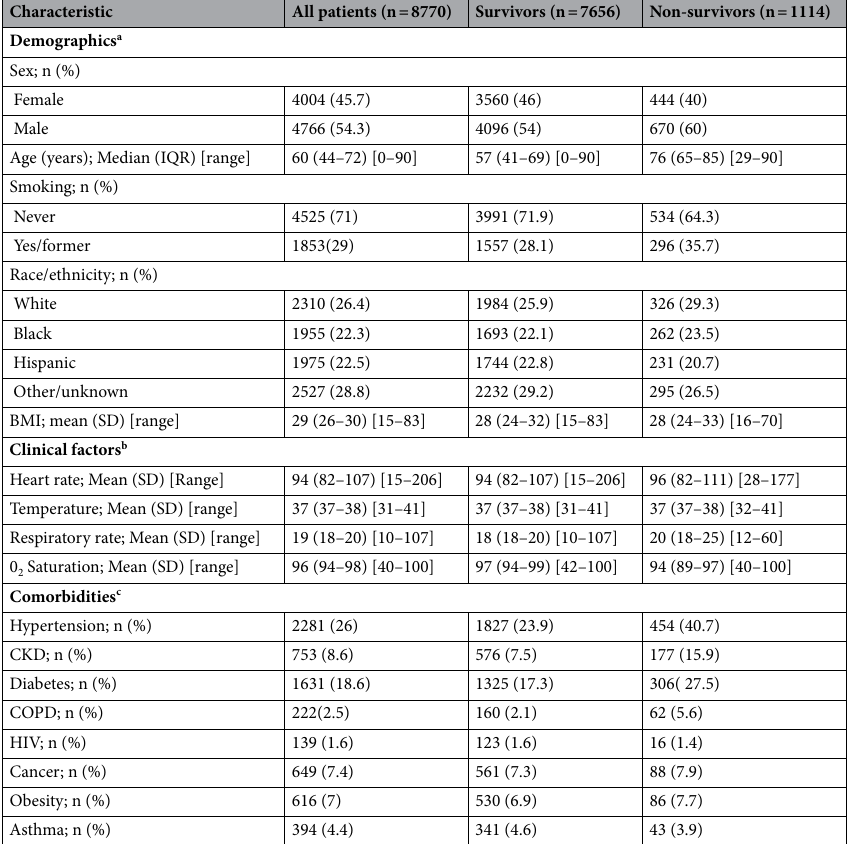
Table 1. Baseline characteristics of 8770 confirmed COVID-19 patients stratified by survival. BMI body mass index, CKD chronic kidney disease, COPD chronic obstructive pulmonary disease, HIV